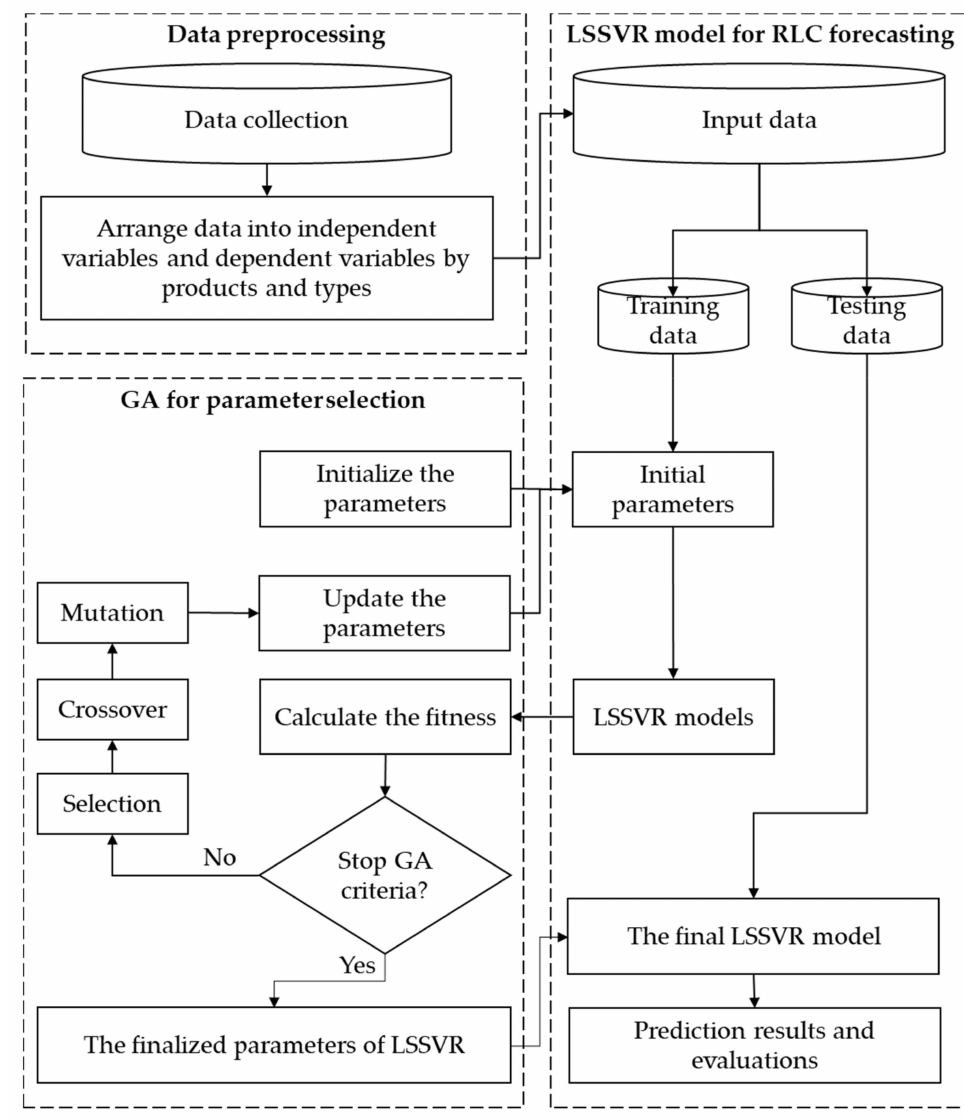
Figure 4. The framework of LSSVR-GA model for RLC values prediction. Table 2. The features and samples in predicting RLC for different substrate